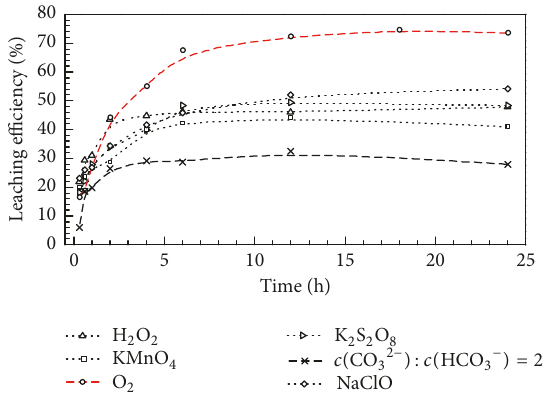
Figure 5: The leaching efficiency of uranium from lignite over a period of